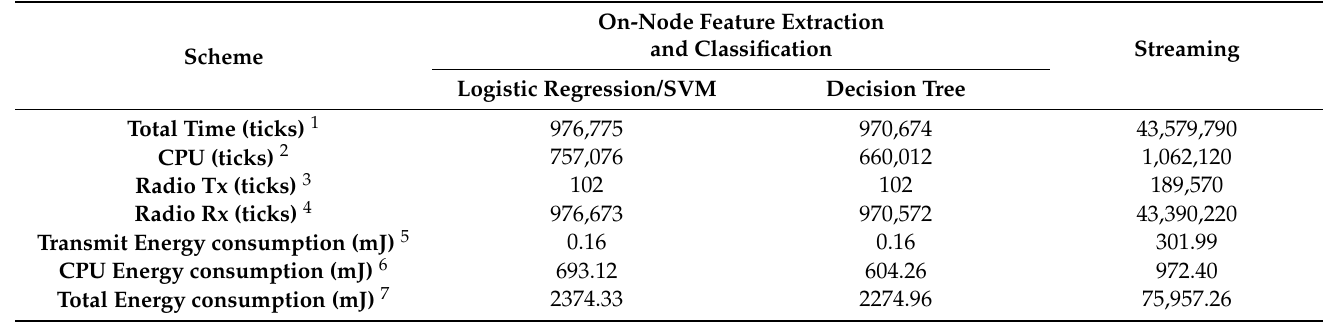
Table 8. The energy consumption of our proposed scheme and streaming